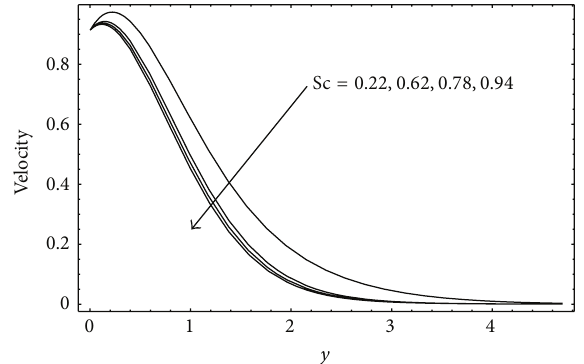
Figure 9: Velocity profiles for different values of 𝜔𝑡 when 𝑡 = 1,𝑅 = 0.5, Pr = 100, Gr = 2, Gm = 0.2, Sc = 0.94 , and 𝛾 = 0.01